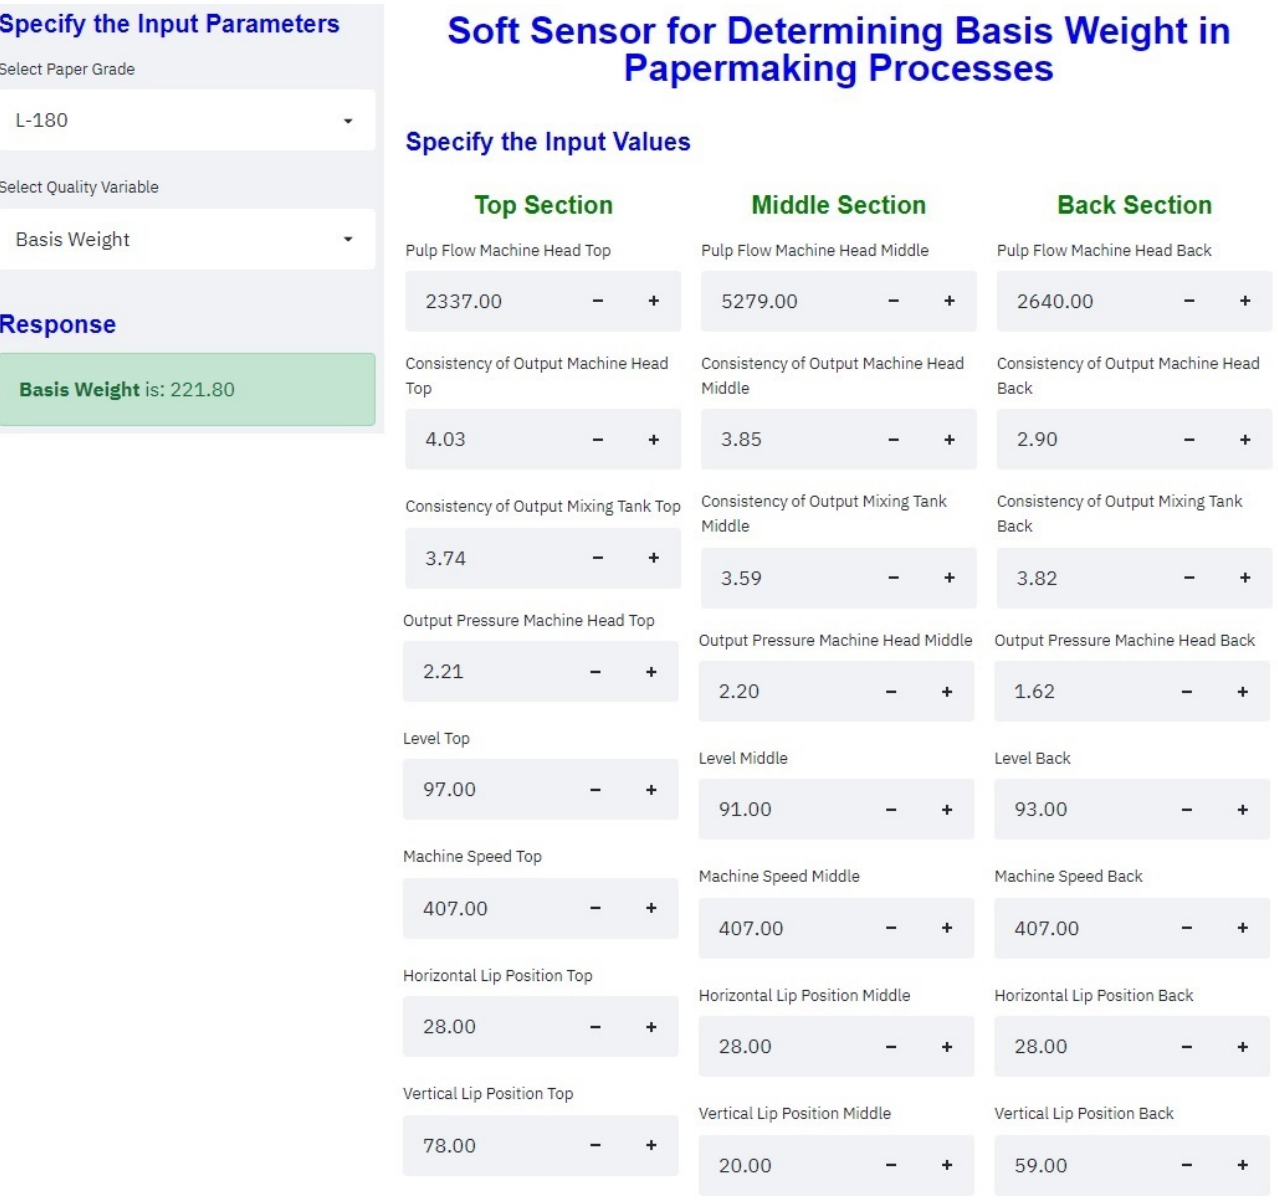
Figure 5. Graphic user interface (Reproduced with permission from [83]).